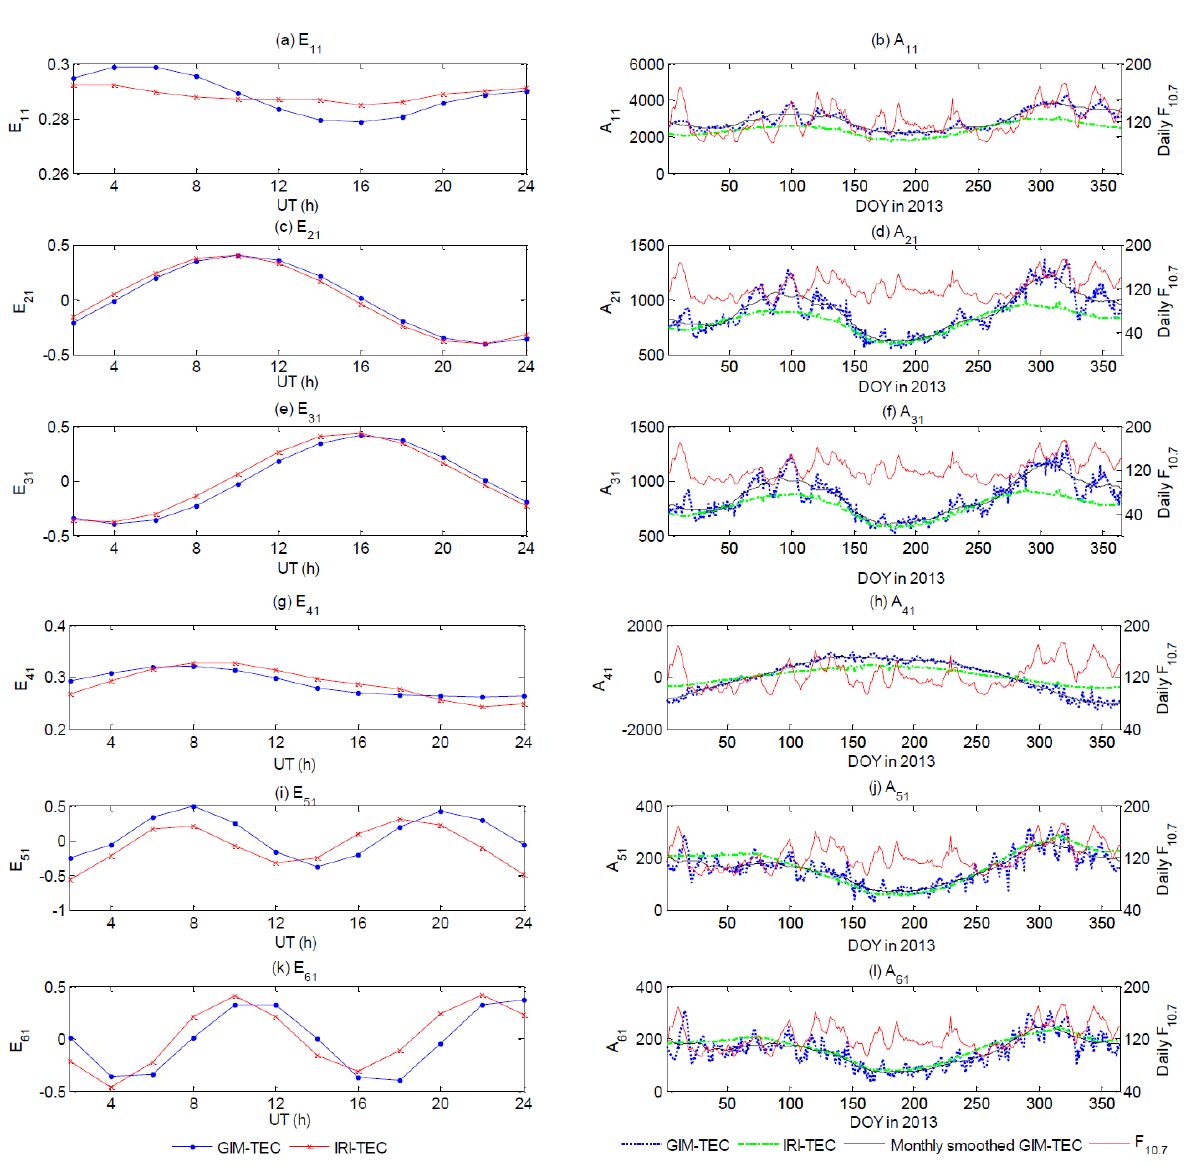
Figure 10. First base function E i 1 and associated coefficient A i 1 of the six coefficients A 1 – A 6 according to Eq. (12). The monthly smoothed A i 1 of GIM-TEC and daily solar F10.7 index are shown together with A i 1